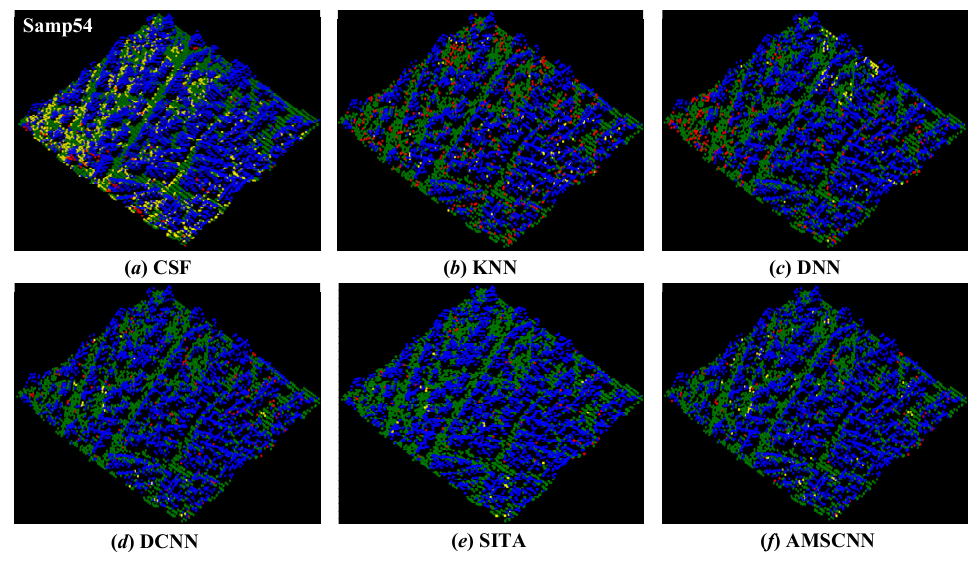
Figure 12. The filtering results of six methods on Samp54. ( a ) CSF; ( b ) KNN; ( c ) DNN; ( d ) DCNN; ( e ) SITA; ( f ) MSCNN-AM. Table 5. Comparison of the filtering performance of six different filtering methods upon the dataset of